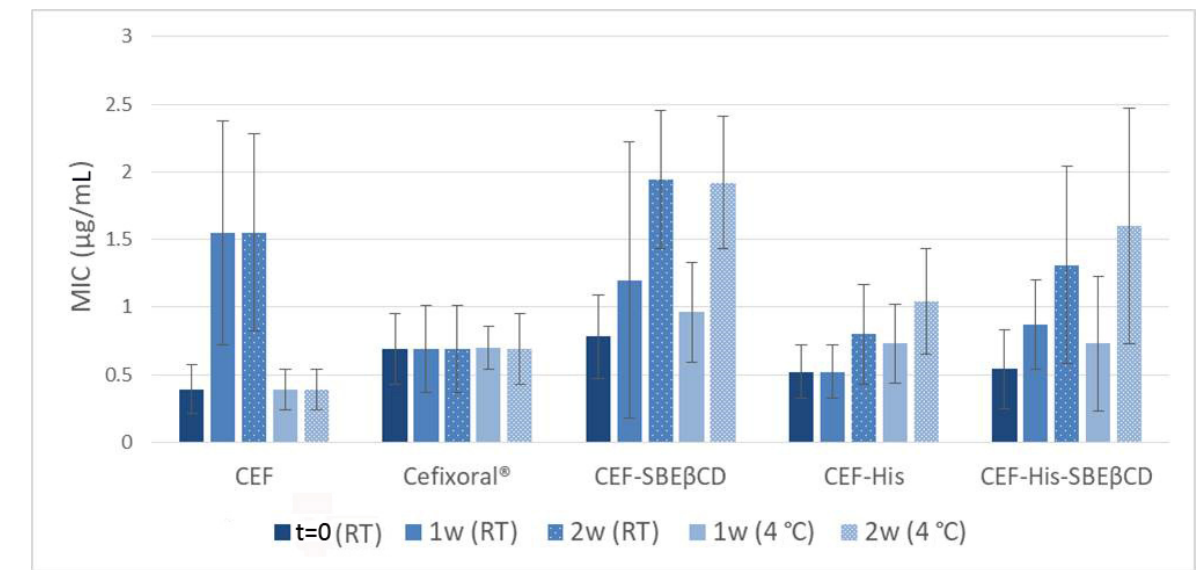
Figure 7. Minimum Inhibitory Concentration (MIC) values of CEF and its different formulations against E. coli at t 0 and after 1 and 2 weeks of storage at room temperature (RT) or at 4 °C.